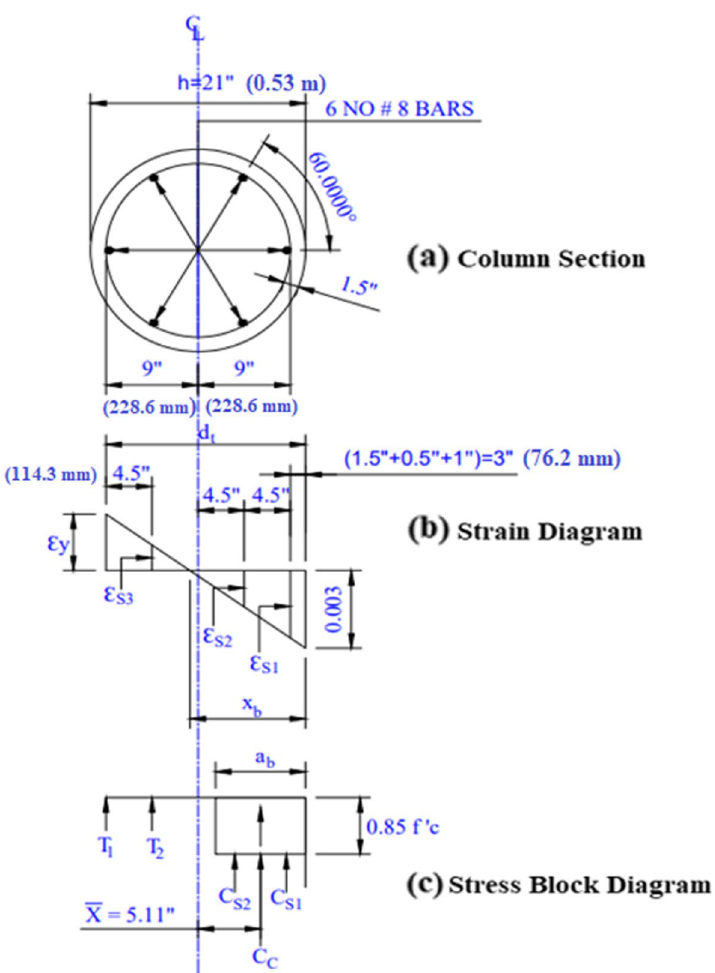
Fig. 2 Column section with strain and stress block